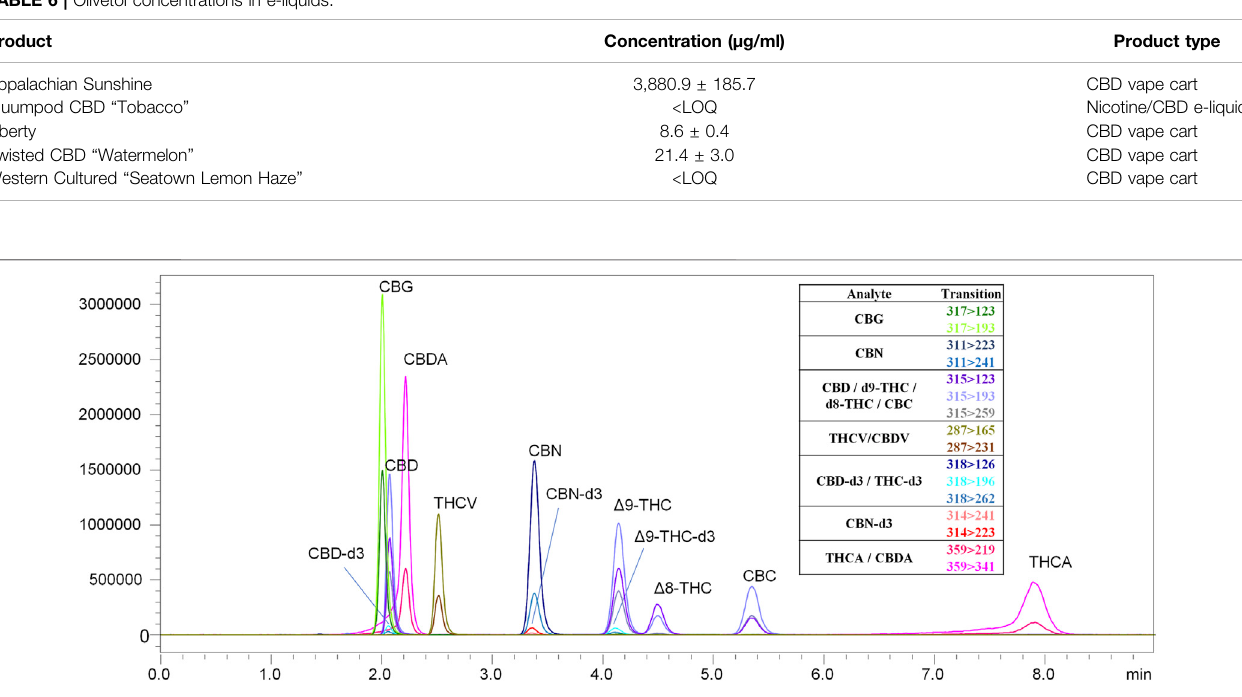
Frontiers in Chemistry |